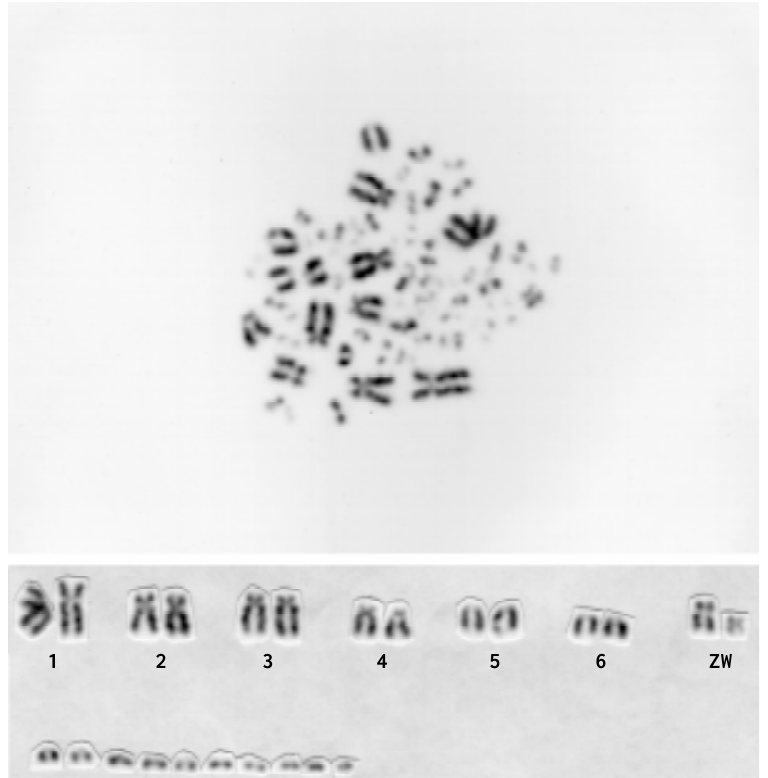
Figure 2 - Chromosomes of a female Oryzoborus maximiliani with a metaphase plate and partial